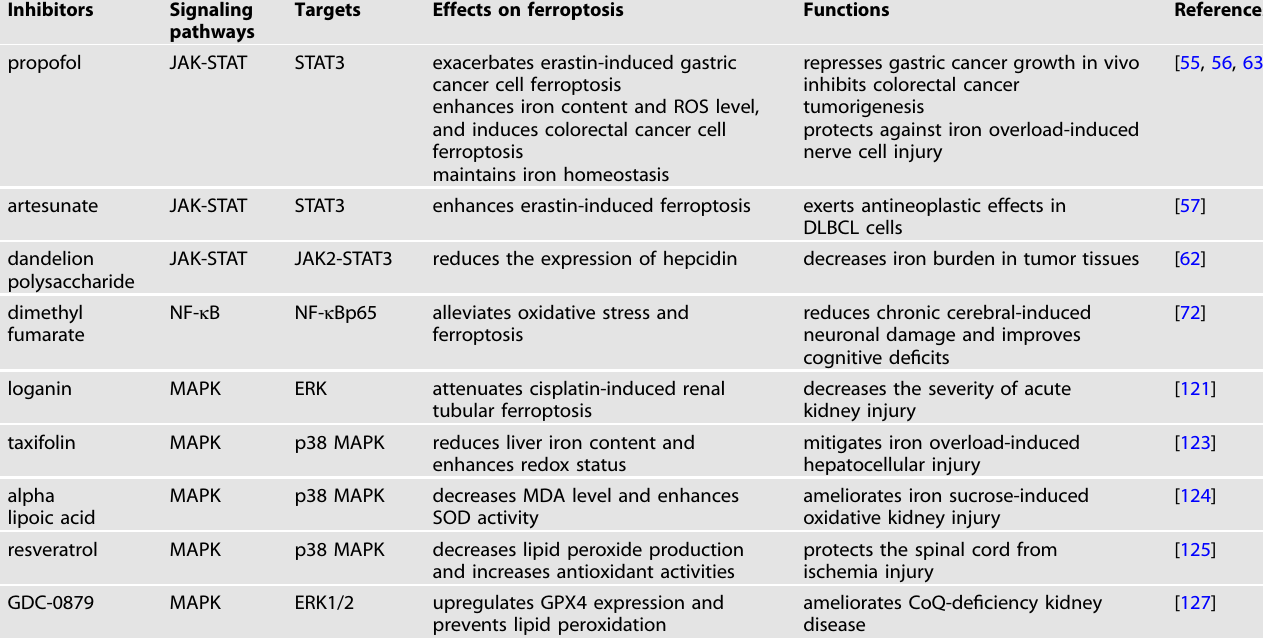
Table 1. The functions of agents targeting in fl ammatory signaling pathways in ferroptosis-related diseases. Inhibitors Signaling pathways